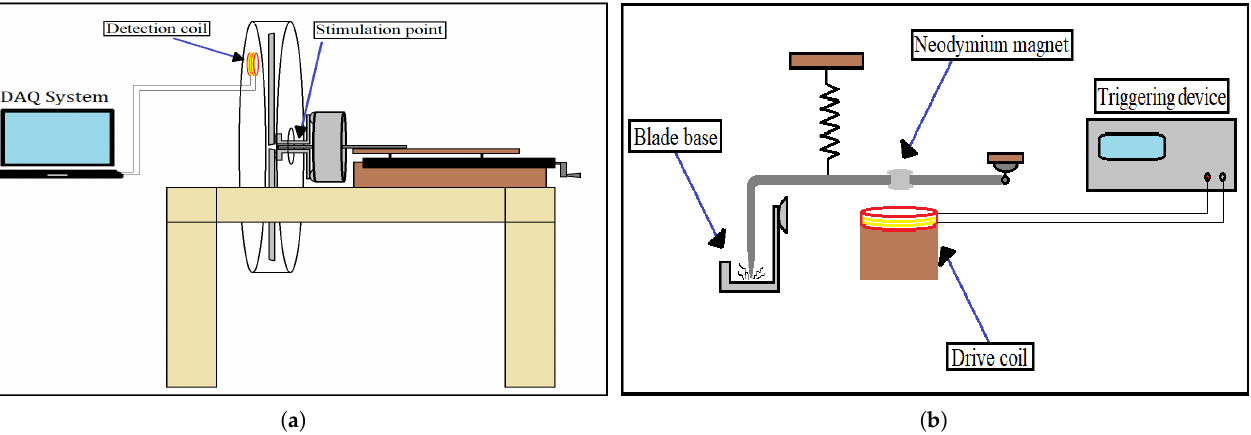
Figure 5. ( a ) Schematic of the experimental setup. A detection coil connected to a laptop was used to detect the vibrations of the rotating blades. ( b ) Schematic of the mechanical stimulation system. The edge point of the Γ -shaped rod excites the stimulation point shown in Figure 5a.